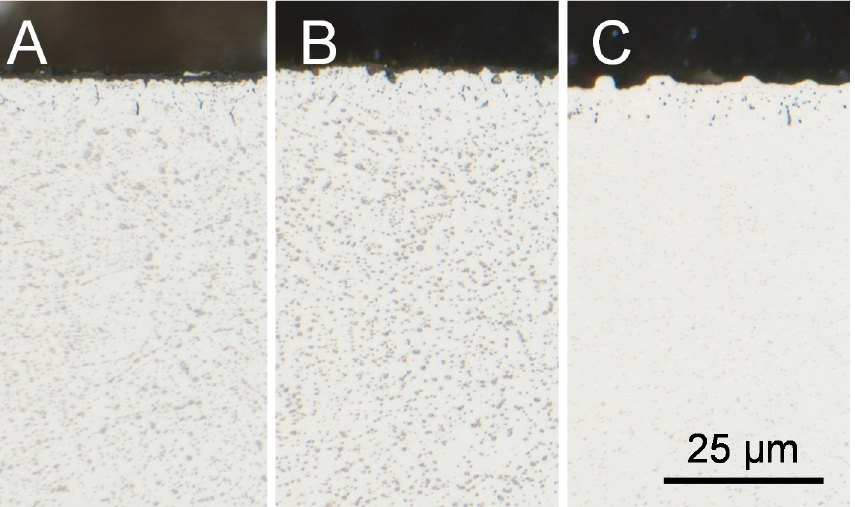
Figure 3. Unetched cross sections of the material X38CrMoV5-3 after the carbonitriding treatments (for heat treatment parameters of ( A – C ) see Table 2).